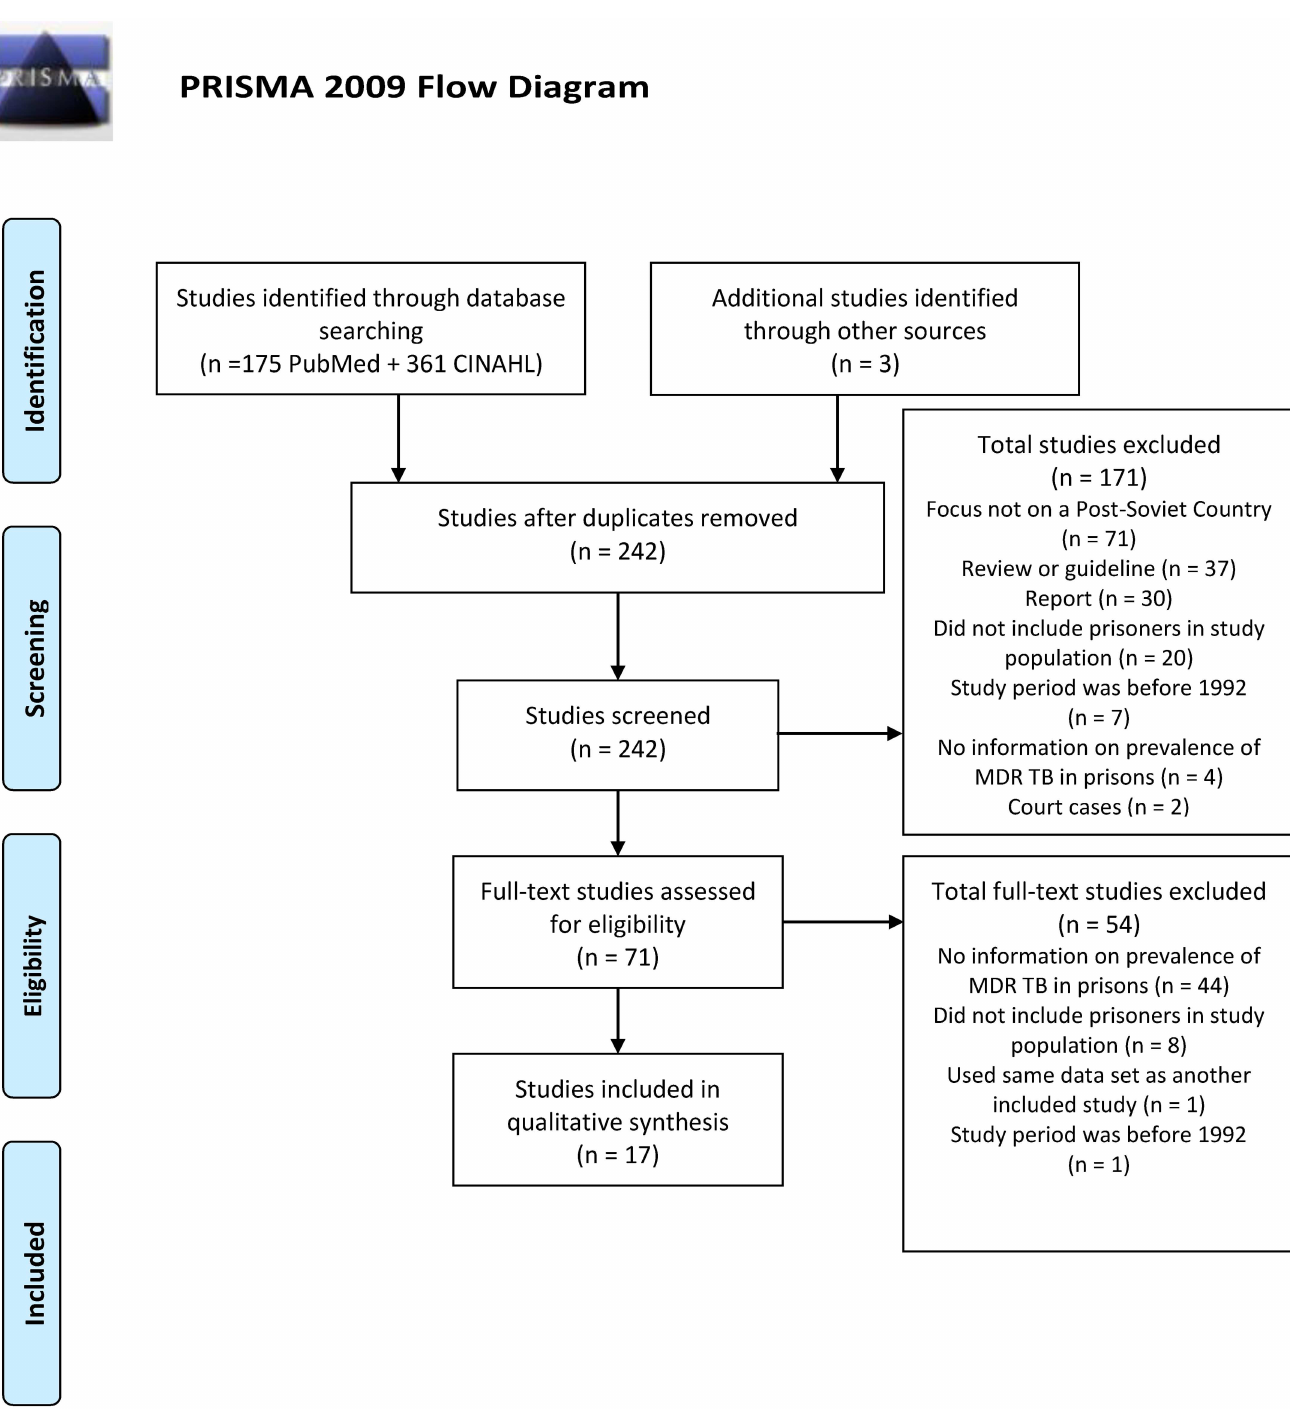
Fig 1. PRISMA 2009 flow diagram. From : Moher D, LiberatiA, Tetzlaff J, Altman DG, The PRISMA Group (2009). P referred R eporting I tems for Systematic Reviewsand M eta- A nalyses: The PRISMA Statement. PLoS Med 6(7): e1000097.doi: 10.1371/journal.pmed1000097. For more information, visit